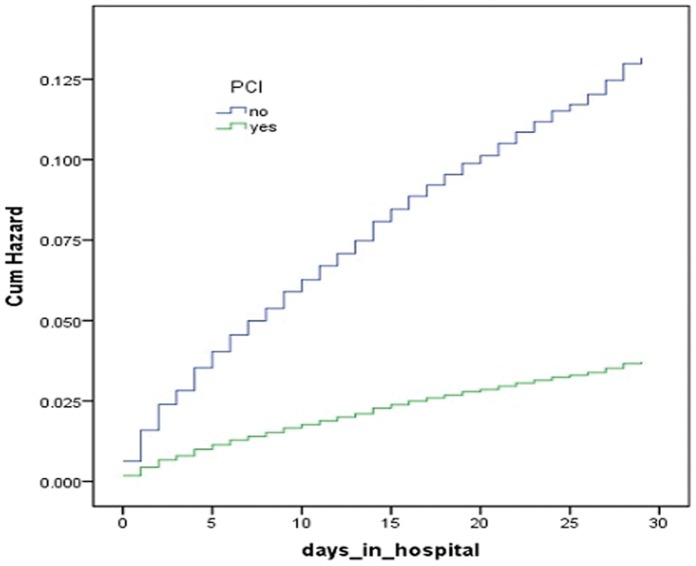
Predicted cumulative hazard function of 30 days mortality for different therapies.The curves were constructed according to the PCI or conservative therapie with the use of Cox regression analysis.